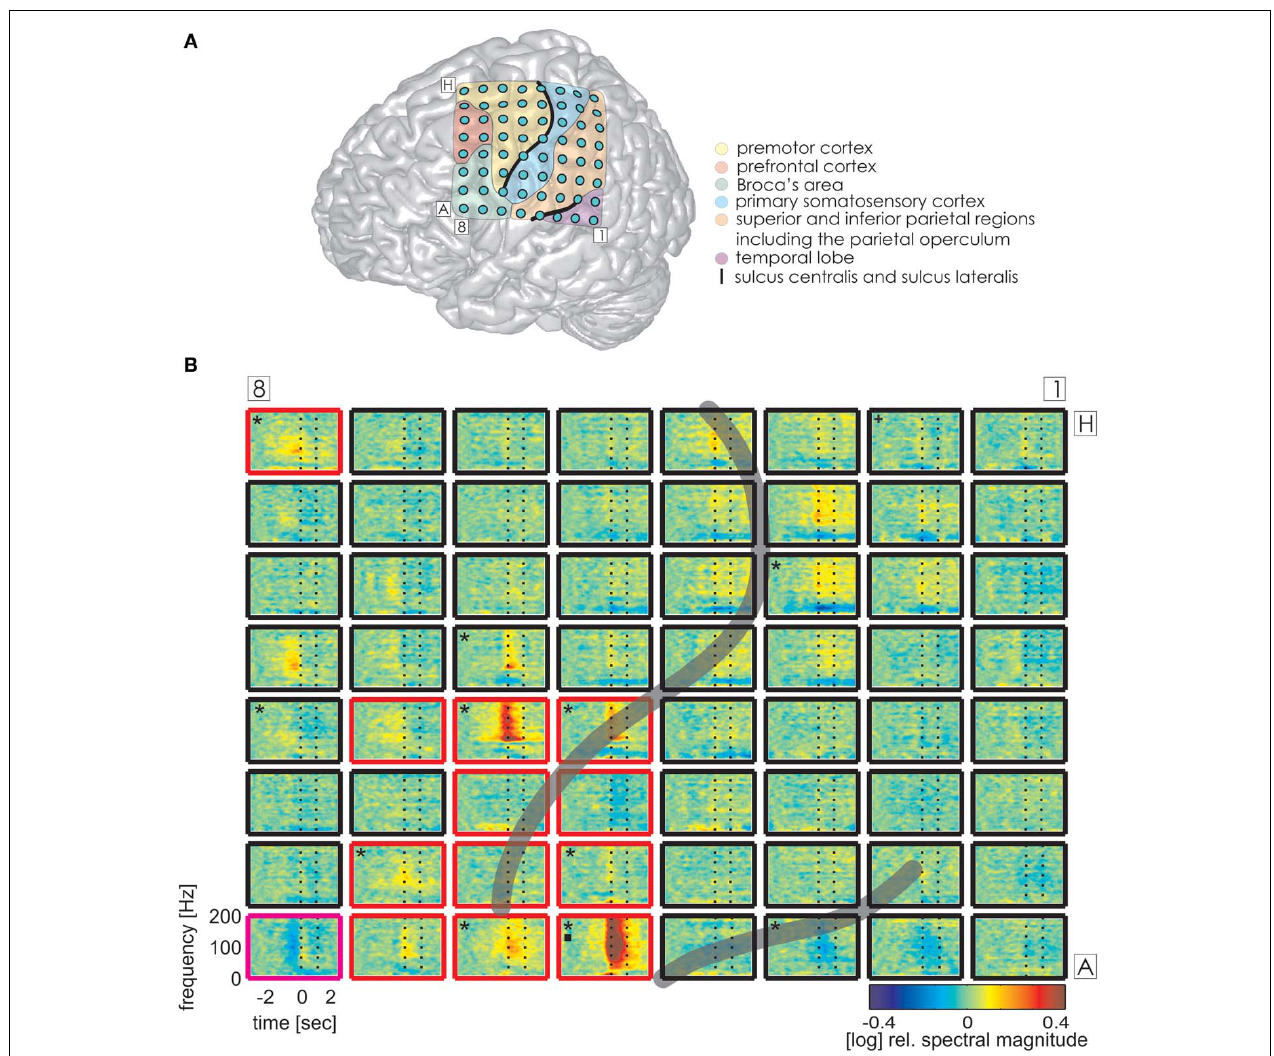
FIGURE 3 | Trial-averaged, time-resolved relative spectral magnitude changes of IU-related brain activity in S1. (A) The individual location of the 8 × 8 electrode grid and the anatomical assignment of the electrodes (see Methods) are visualized on a Colin standard brain from SPM5 based on the MNI coordinates of the electrodes. Results of the anatomical assignment procedure are color-coded (see legend). (B) Cortical responses underlying the production of IUs averaged across 600 trials. Each of the 64 panels corresponds to the respective electrodes in (A) . The left vertical dashed line marks the onset (0s), the right vertical dashed line marks the average end of